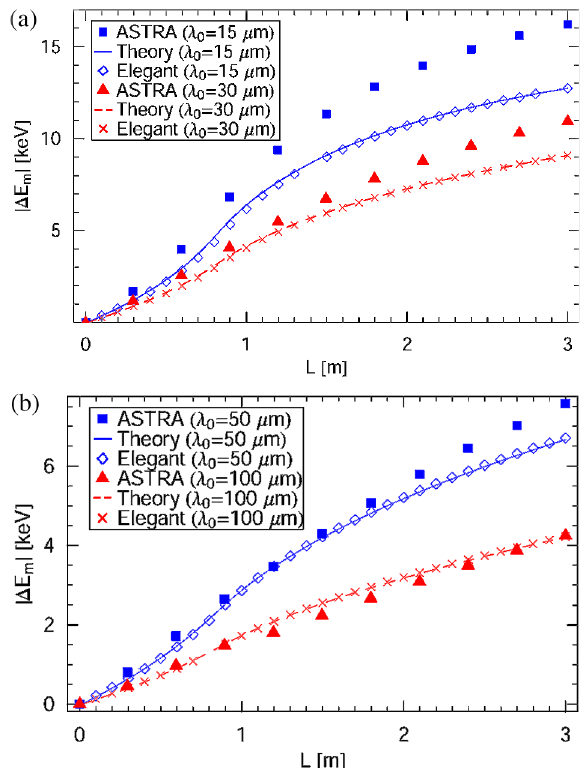
2. (Color) Accumulated energy modulation